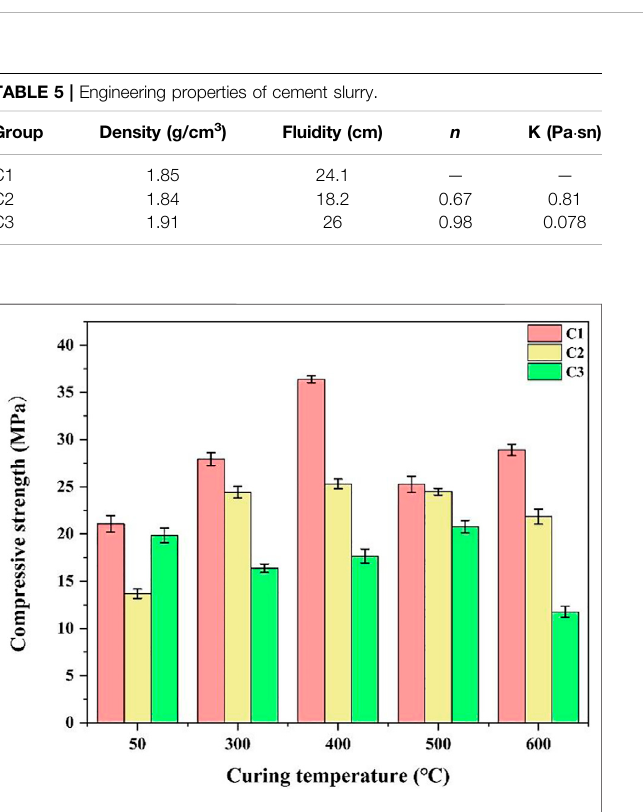
FIGURE 3 | Compressive strength of cement paste cured at different